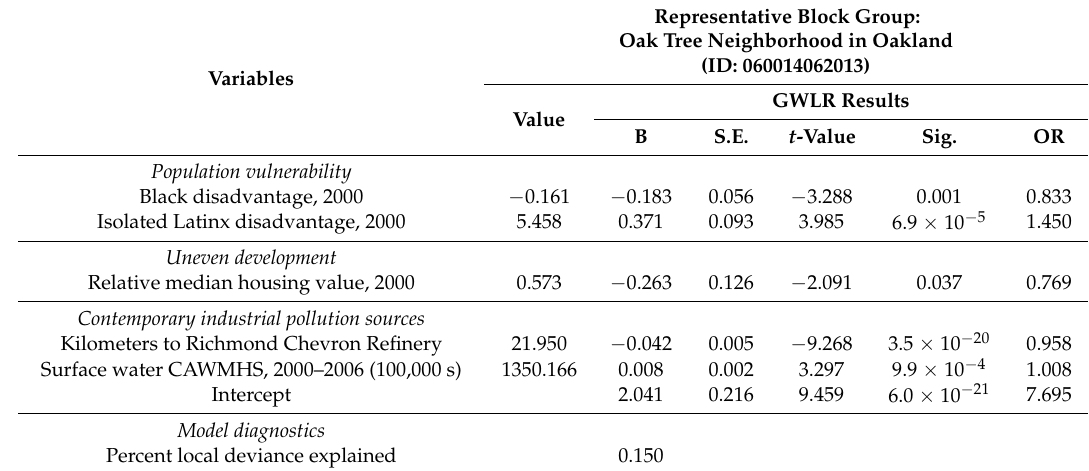
Figure 13. Modal GWLR results in the Map ( A ) Bay-Delta and Map ( B ) the Oakland-Alameda- Piedmont Area. Table 10. Representative block group from modal GWLR results for block group 50 percent areal containment within a 2006, 303(d), impaired water hazard zone on population vulnerability, uneven development, and contemporary industrial pollution source